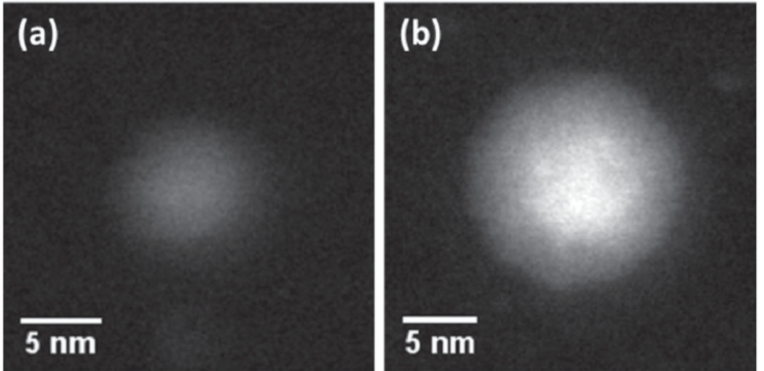
Figure 13. Demonstration of the transition from a core–shell to alloy structure with decreasing size for W@Fe nanoparticles. ( a , b ) HAADF-STEM images of a 6 nm and a 15 nm Fe-W nanoparticle. The smaller particle shows no core–shell contrast. Reproduced with permission from